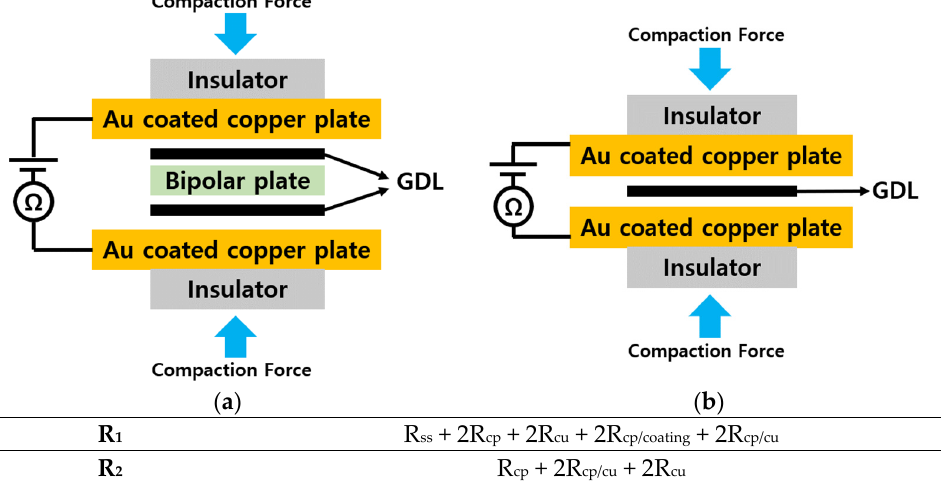
Figure 1. Schematic diagram for measuring interfacial contact resistance. ( a ) R 1 ; ( b ) R 2 .